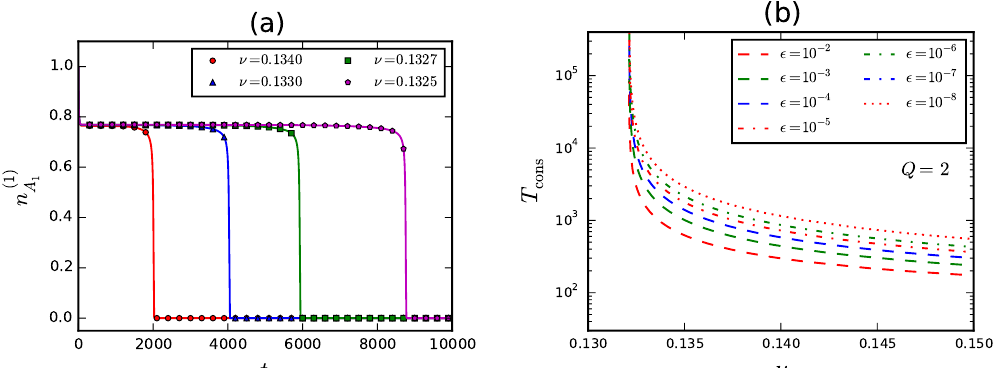
Figure 4. ( a ) Numerical integration of mean field equations (MFEs) in the Planted Partition Model (PPM); ( b ) Time to consensus vs. ν for several values of the symmetry breaking parameter (cid:101) . Table 3. Estimates of fit parameters for T cons ( ν , (cid:101) ) .